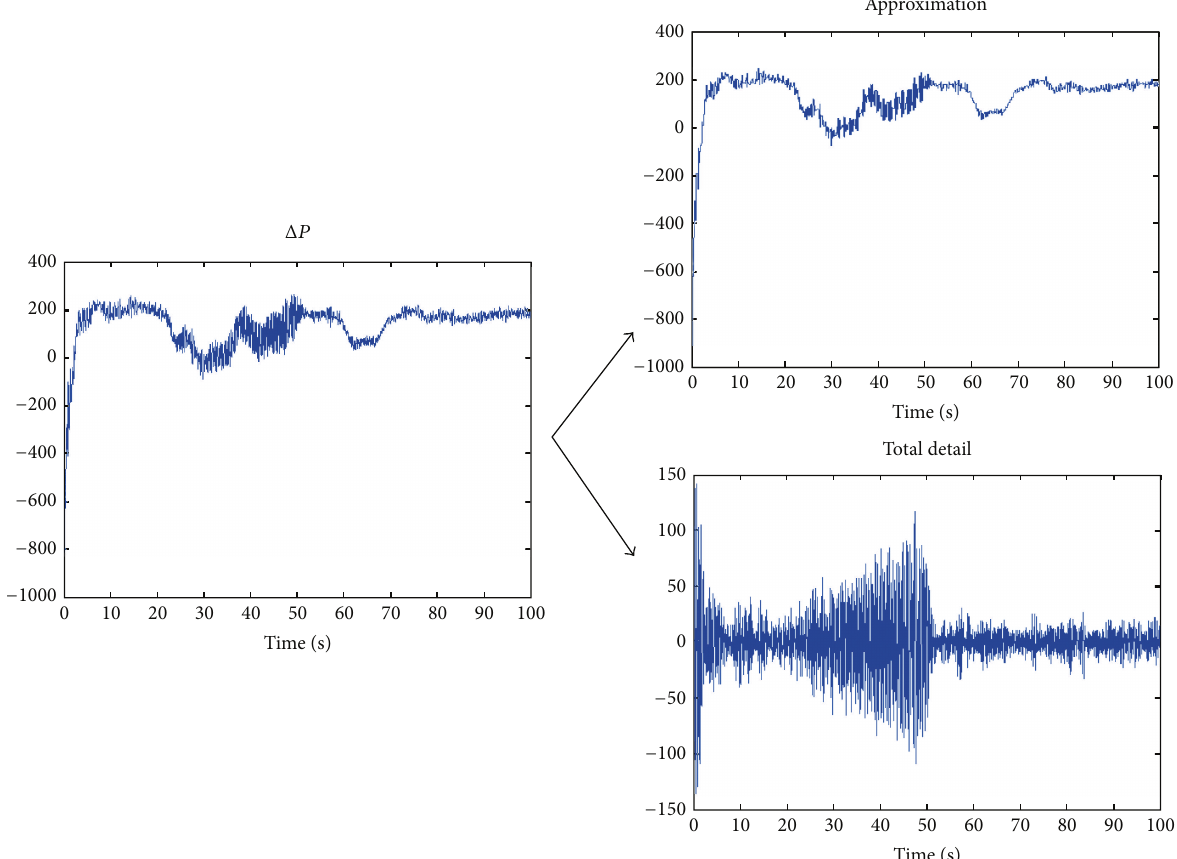
Figure 8: Decomposition of power difference Δ𝑃 using Haar wavelet transform.